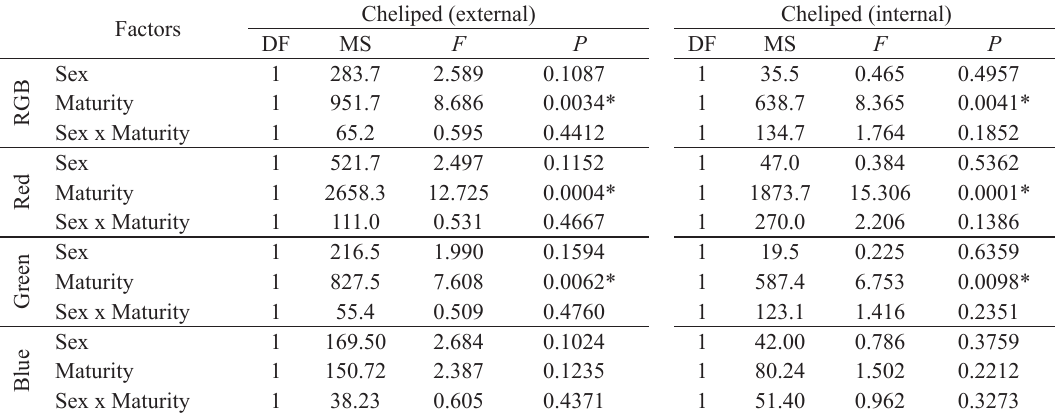
Comparison of the chelipeds (external and internal surface) of Charybdis hellerii with the color spectra (RGB, red, green and blue) by two-way ANOVA; the first factor is the sex and the second is sexual maturity. DF = degrees of freedom, MS mean square, F = F test value, * =P < 0.0125 (Bonferroni